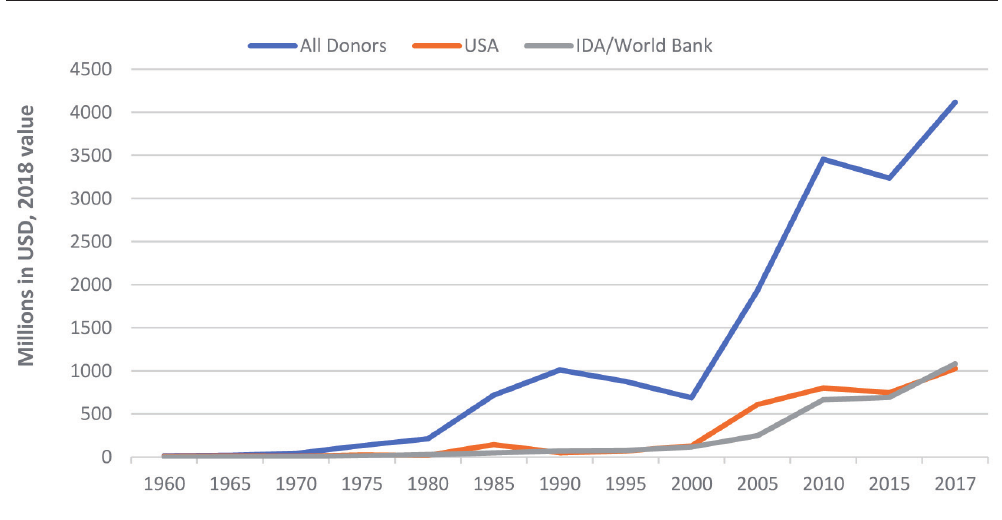
Figure 1: Official development aid to Ethiopia (disbursement, 1960–2017); organized and based on data from OECD’s Query Wizard for International Development Statistics